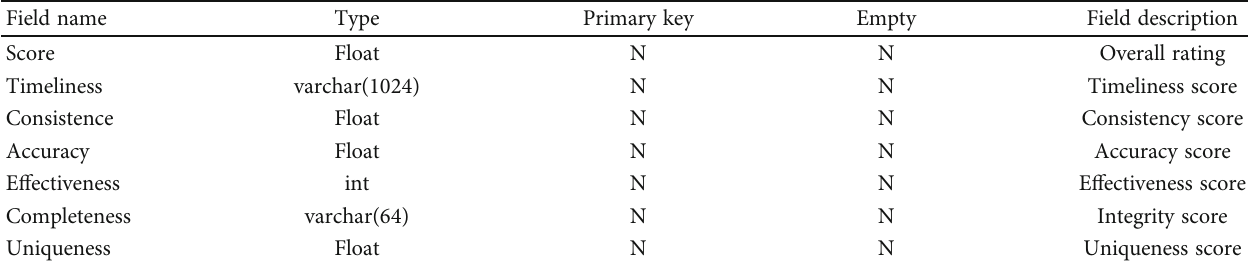
Table 2: Quality report form.